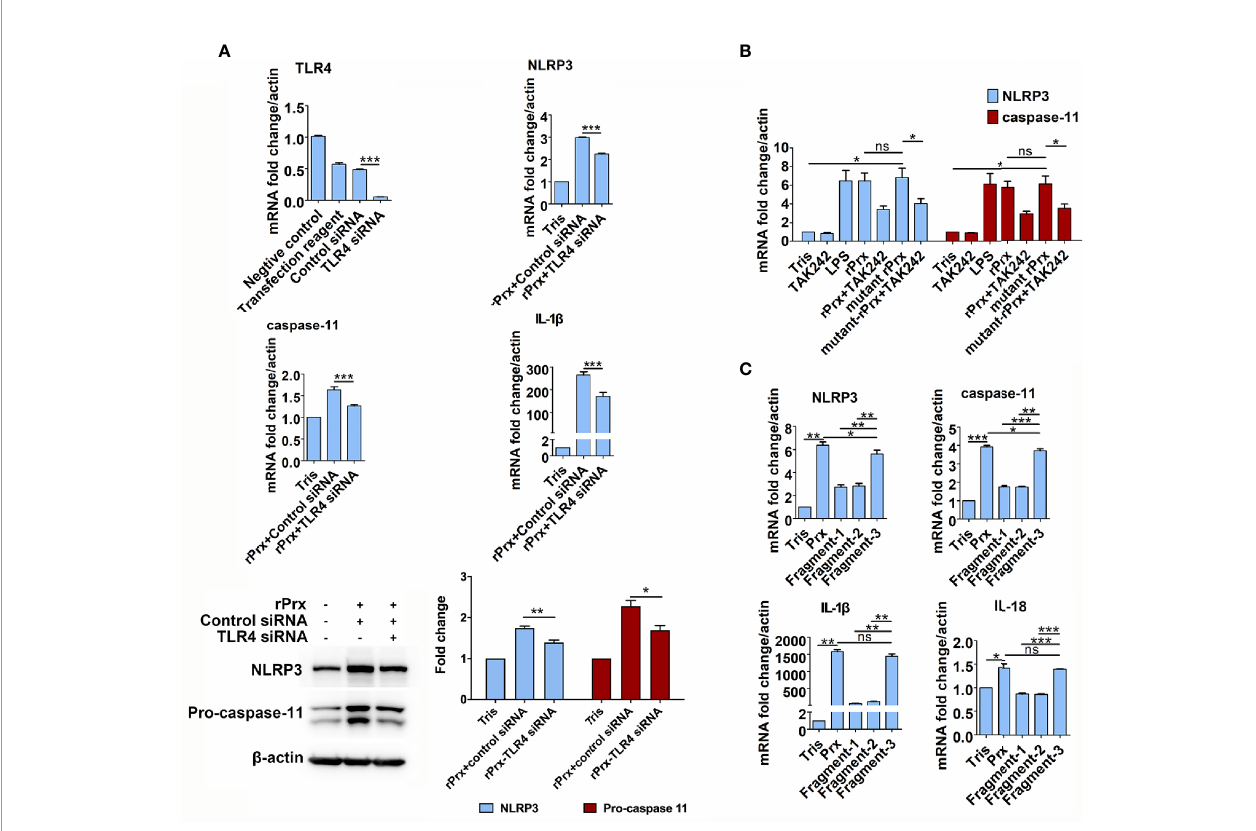
FIGURE 4 | Mechanism of Eh -rPrx recognition via TLR4 receptor. (A) Eh -rPrx recognition through TLR4 receptor was con fi rmed via TLR4 siRNA. RAW264.7 cells were treated with control siRNA (50 nM) and TLR4 siRNA (50 nM) for 24 h. Next, the supernatant was removed, and the cells were treated with Eh -rPrx (5 m g/mL) for 6 h. Expression levels of NLRP3-related genes and proteins were detected by qPCR and w estern blotting, respectively. In all groups, n = 3. Experiments were repeated three times. (B) Activation of NLRP3 In fl ammasome independently of Prx ’ s reductase activity. Eh -rPrx functioned independently of antioxidant activity. For detection of NLRP3-related gene expression levels, RAW264.7 cells were pretreated with TLR4 inhibitor TAK242 (1 m M) for 1 h, prior to 5 m g/mL of Eh -rPrx or mutant Eh -rPrx. LPS (1 m g/mL) and Tris-HCl (pH 8.0) were used as the positive and negative controls, respectively. Six hours after the treatment, the expression levels of related genes were measured by qPCR and shown as 2- DD Ct of the target gene relative to b -actin, normalized with corresponding values in the negative control. In all groups, n = 3. Experiments were repeated three times. (C) The C-terminal of Eh -Prx was identi fi ed as the functional domain responsible for activating NRLP3 in fl ammasome. Three fragments of Eh -Prx were constructed; fragment-1 to fragment-3 each contained 100 amino acids at the N-terminal, middle segment, and C-terminal. Following incubation of the fragments and RAW264.7 cells for 6 h, the expression levels of related genes were measured by qPCR and shown as 2- DD Ct of the target gene relative to b -actin, normalized with corresponding values in the negative control. In all groups, n = 3. Experiments were repeated three times. Statistical analysis was conducted by Student ’ s t -test, and data are expressed as mean ± SEM. *p < 0.05, **p < 0.01, ***p < 0.001, ns, not signi fi